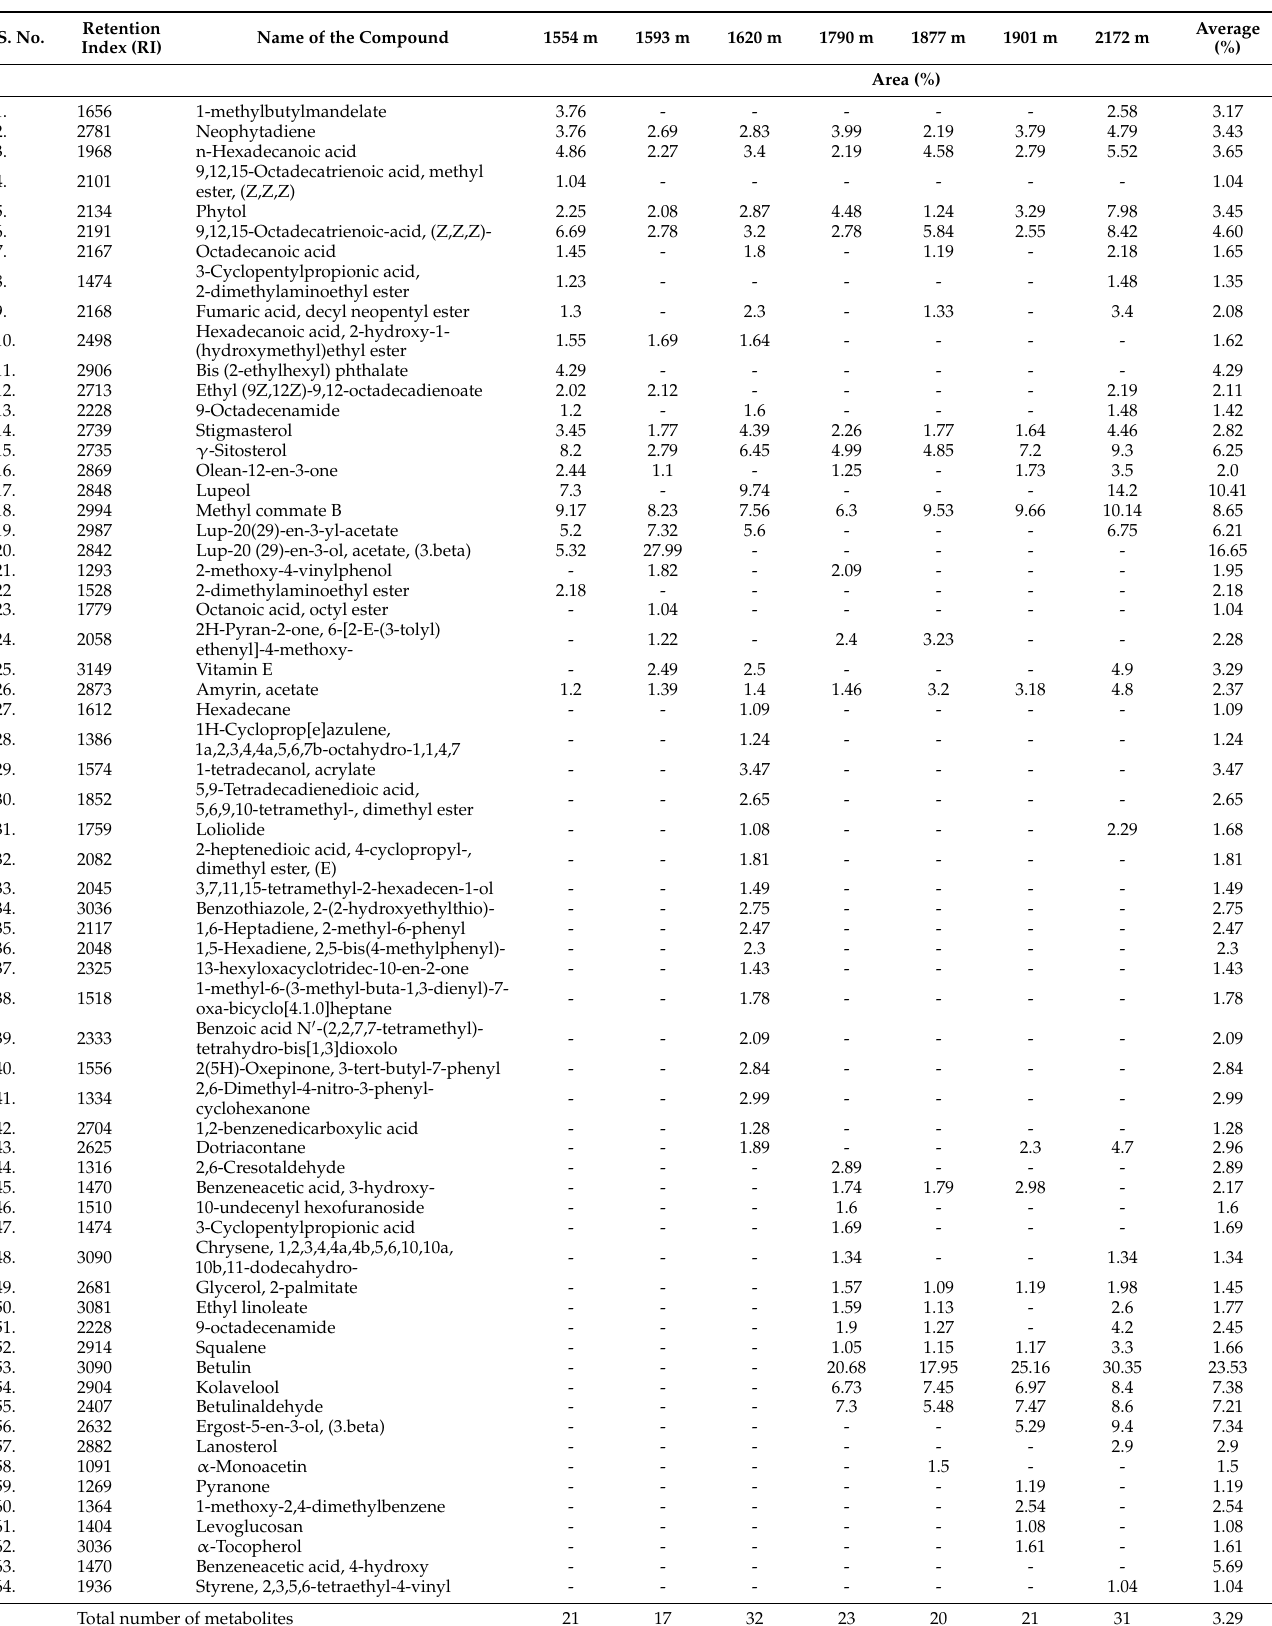
Table 2. GC-MS analysis of C. intybus L. (chicory) from different